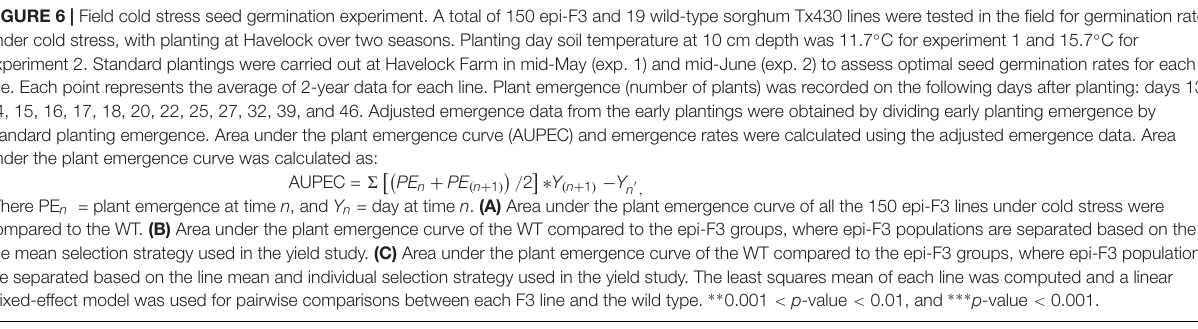
Frontiers in Plant Science |